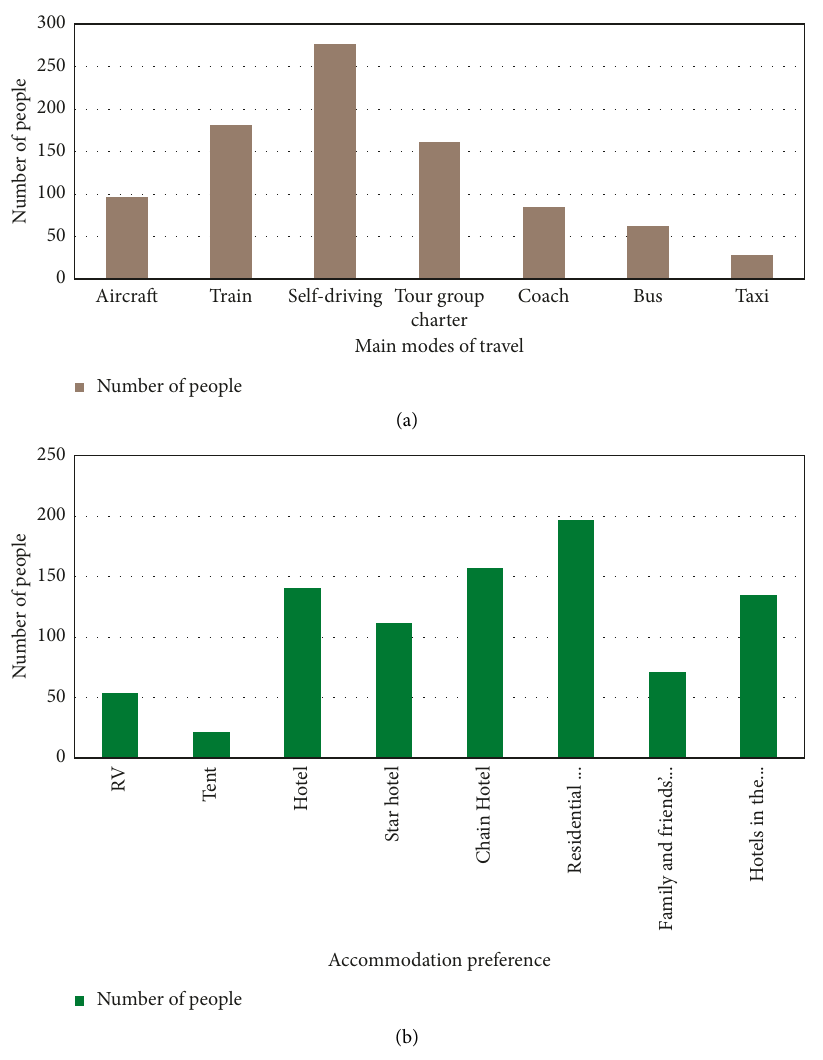
Figure 10: Analysis of (a) consumers’ experience and (b) preference of sports tourism in a